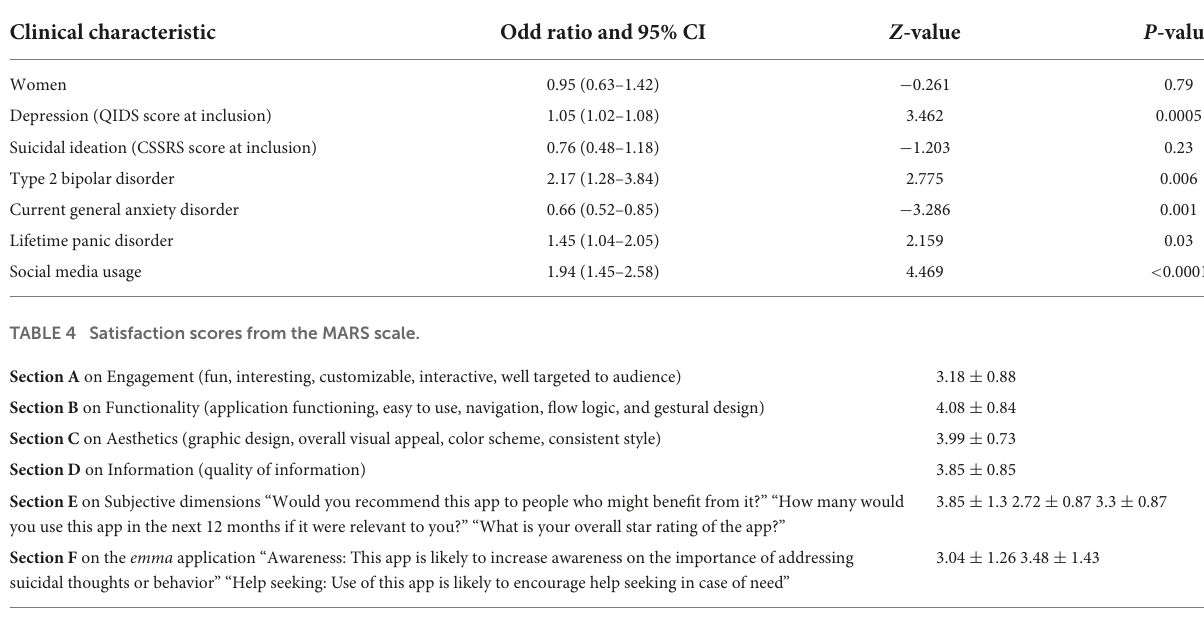
TABLE 3 Multivariate analysis for the daily completion rates.